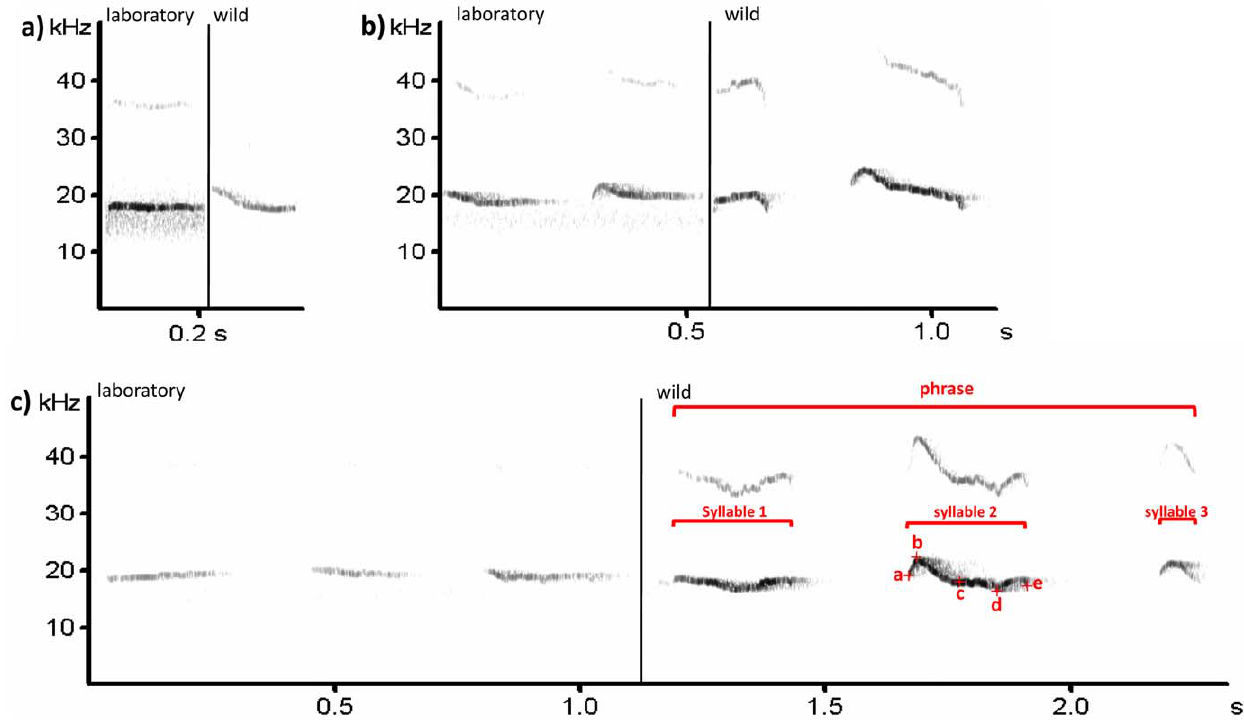
Figure 1. Spectrographs of representative USVs from P.californicus in the wild and laboratory. 1 syllable vocalization (1SV; n laboratory =25, n wild =6; Audio S1), b) 2SV (n laboratory =23, n wild =8; Audio S2), and c) 3SV (n laboratory =27, n wild =10; Audio S3), recorded from P. californicus in the laboratory and the wild. Frequency resolution for the spectrogram included: FFT length of 512, and a 100% Frame size with a Hamming window. Window overlap was 50%. Prior to spectrograph generation, waveforms were copied into the same file. Annotation as follows with each annotation having an associated frequency (y axis) and time (x axis) value: a =start of syllable ( start freq variable); b =maximum frequency of syllable ( max freq variable); c =point of maximum amplitude of syllable ( freq max amp variable); d =minimum frequency of syllable ( min freq variable); e =end of syllable ( end freq variable). Calculations from these annotations as follows: duration of syllable=|time of a – time of e |; bandwidth of syllable=frequency of b - frequency of d ; overall modulation =|frequency of a -frequency of e |/ duration; internal modulation =frequency of b - frequency of d / |time between b and d